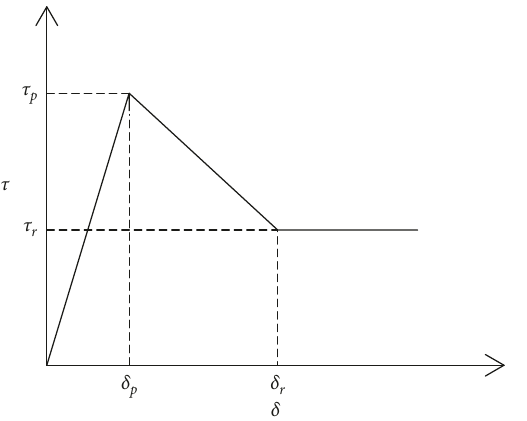
Figure 1: A trilinear model [13, 38,